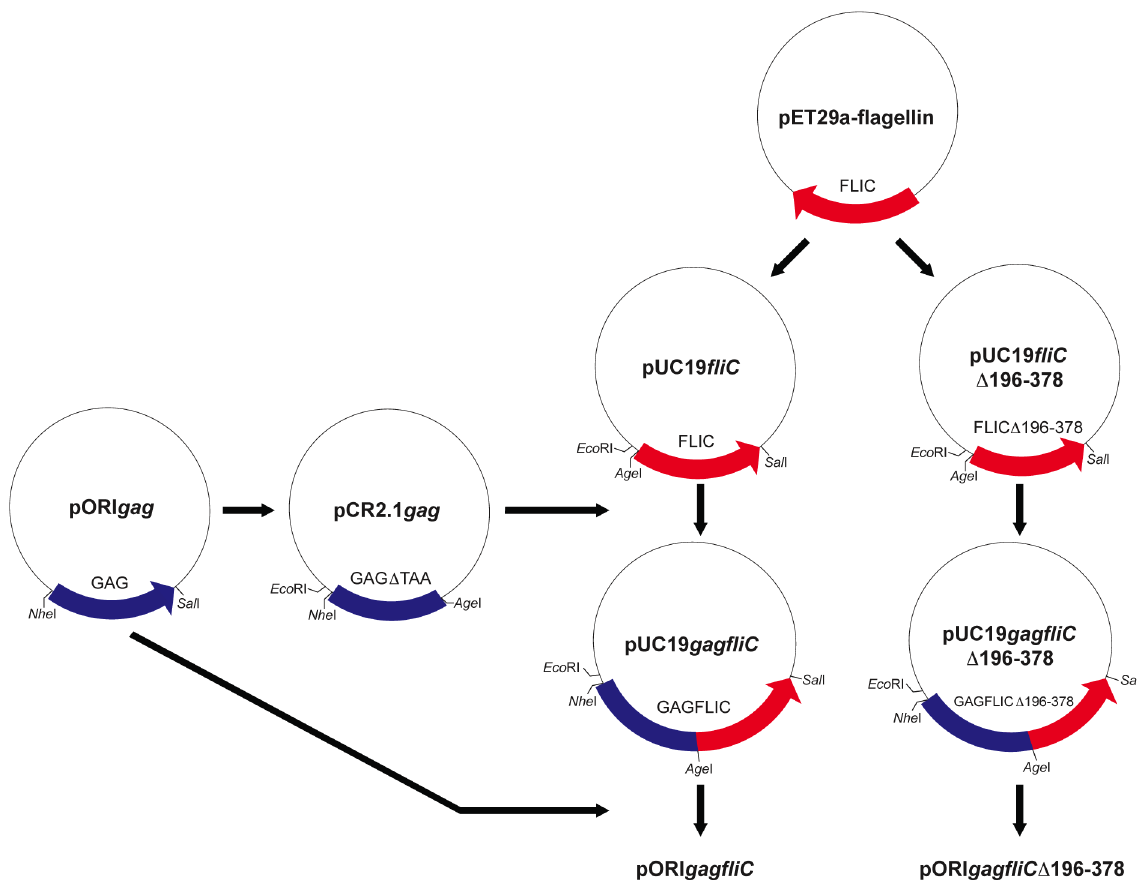
Fig 2. Flow Chart depicting construction of vectors encoding SIV gag Salmonella fliC fusion proteins. Salmonella fliC was cloned in frame downstream of the SIV gag gene. The final fusion construct encoded a single Kozak sequence and translation start codon at the 5 ’ end, and a single stop codon at the 3 ’ end. A single AgeI restriction endonuclease recognition site separated the two